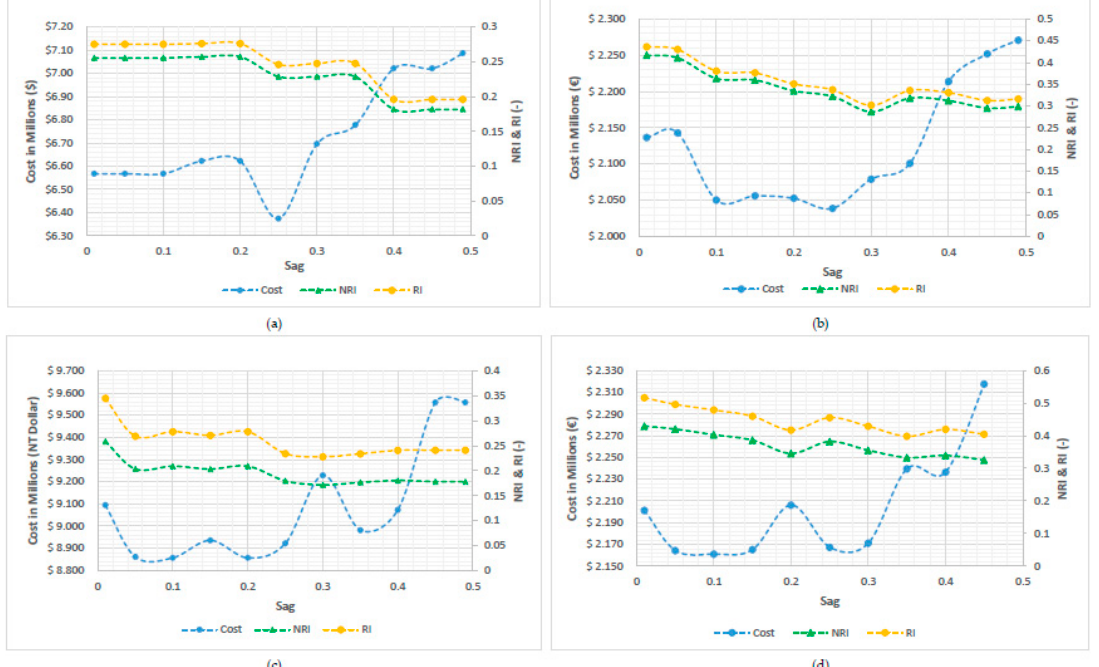
Figure 13. Sensitivity Results for Cost and Network Resilience Index (NRI) for Different Values of Sag ( a ) Hanoi Network. ( b ) Balerma Network. ( c ) Taichung Network ( d ) Pescara Network.